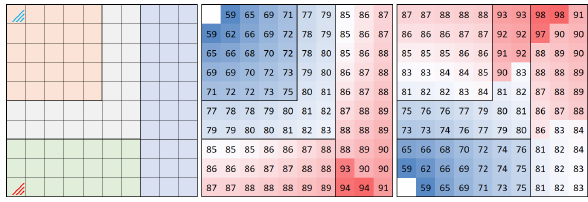
Figure 2. Signal coverage across the zones, under an obstructed